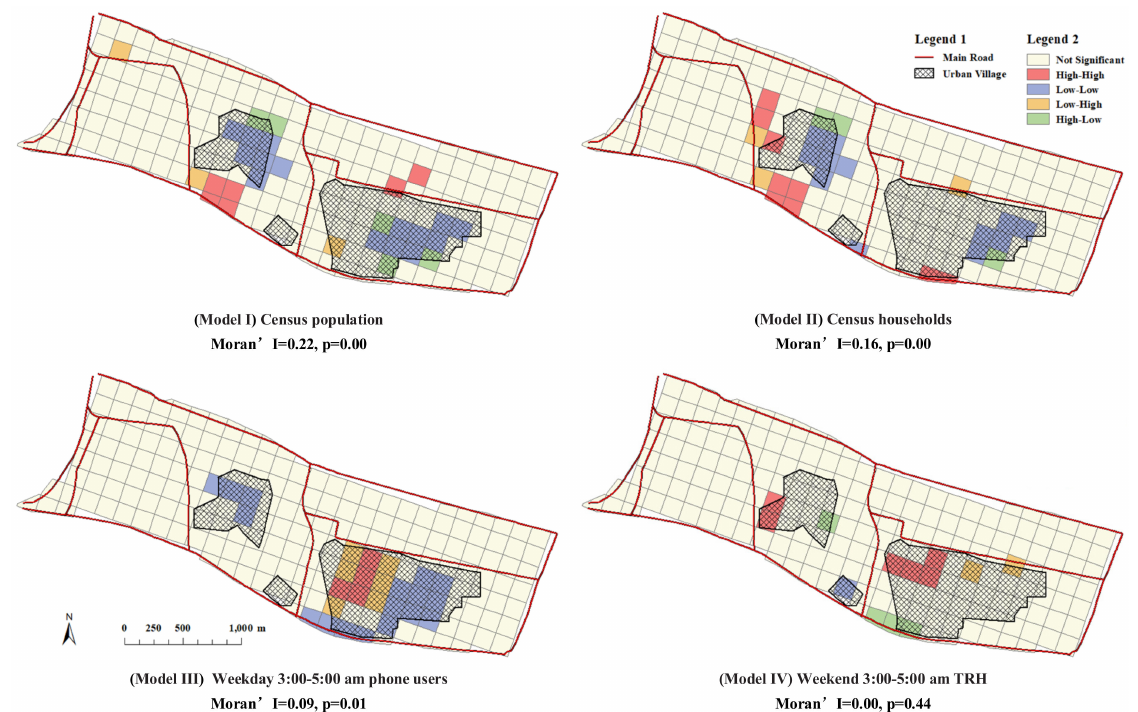
Figure 6. Residual clusters of various residential population indicators in the negative binomial regression model (N = 192 sample grid